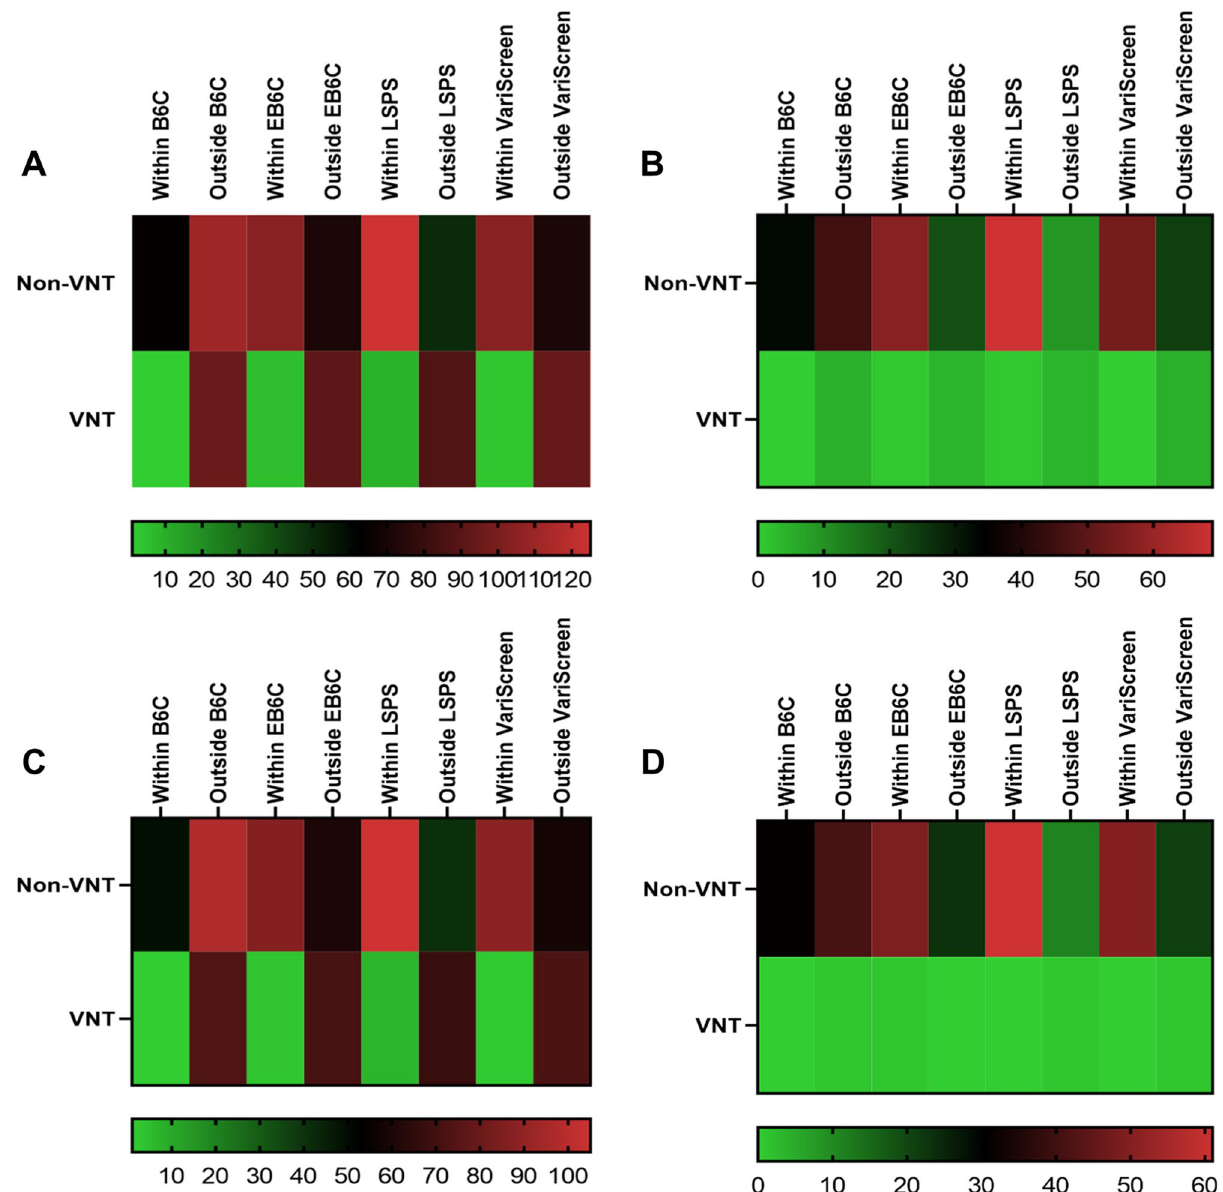
Figure 2. Heat map of subgroups. ( A ) cirrhotic patients; ( B ) Non-cirrhotic patients; ( C ) patients receiving antiviral treatment; ( D ) patients non-receiving antiviral treatment; VNT, varices needing treatment Imaging software: GraphPad Prism (version 7; GraphPad Software Inc., San Diego, CA): https ://www.graph pad.com/ scien tific -softw are/prism